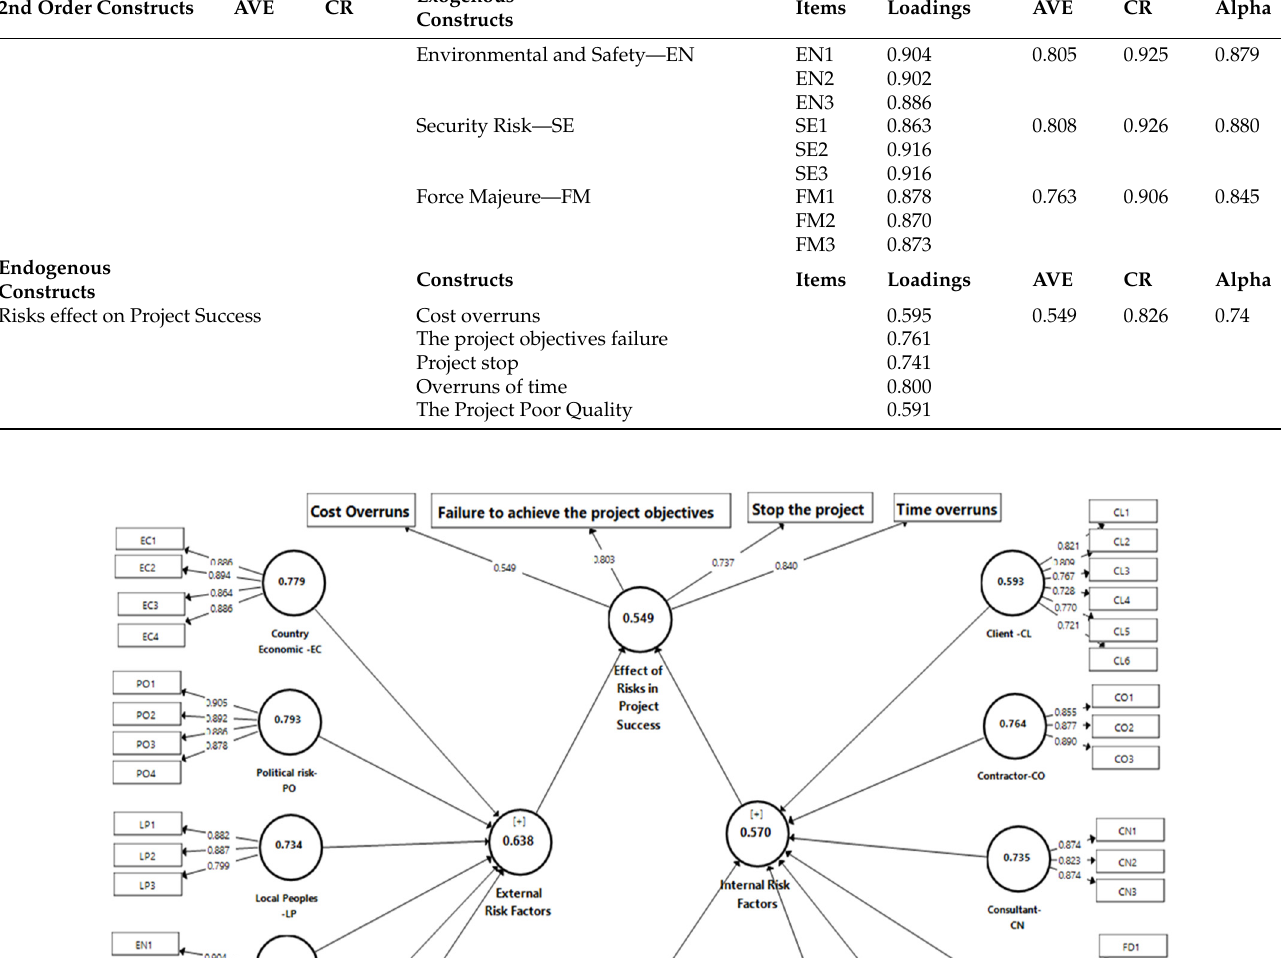
Figure 6. The Testing of Outer Loading Relevance. b. The Discriminant Validity The discriminant validity based on [56] is the concept’s empirical differentiation from other constructs. Nonetheless, discriminating validity implies that the concept is distinct from other constructs in the model.